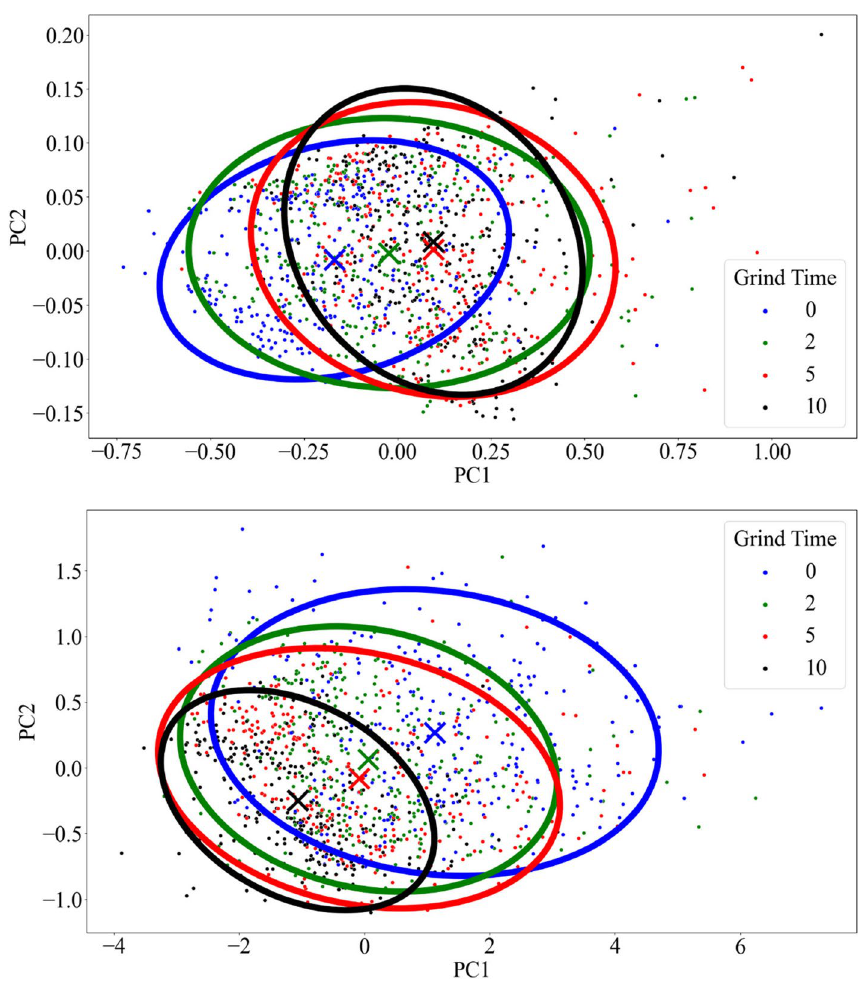
Figure 3. 95% confidence ellipses of sample spectral data for ATR (top) and DRIFT (bottom) spectroscopy in PC space for different levels of grinding (minutes). Measures of the center for each confidence ellipse are indicated by the ‘x’ corresponding to the category